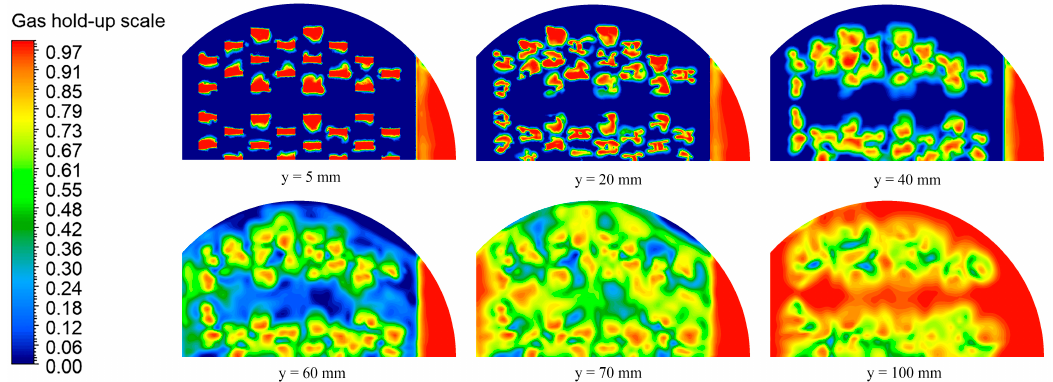
Figure 9. Gas hold–up snapshots of the top view at different heights of the rectangular guided valve tray.